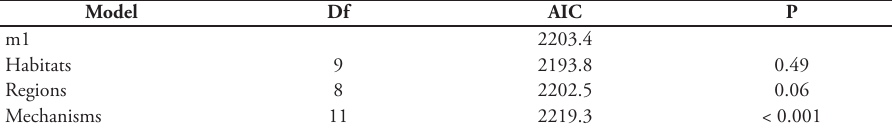
Table 2. Cumulative link mixed effects model estimating the effect of habitat, region and impact mecha- nism on overall impact magnitude of the studied alien grasses (m1). The significance of predictor variables was determined using single-term (predictor) deletion models tested against the full model. Models were run with species identity, and mechanism nested within mechanism type (environmental or socio-eco- nomic) as random factors. AIC is the Alkaike’s Information Criterion, and P is the chi-squared